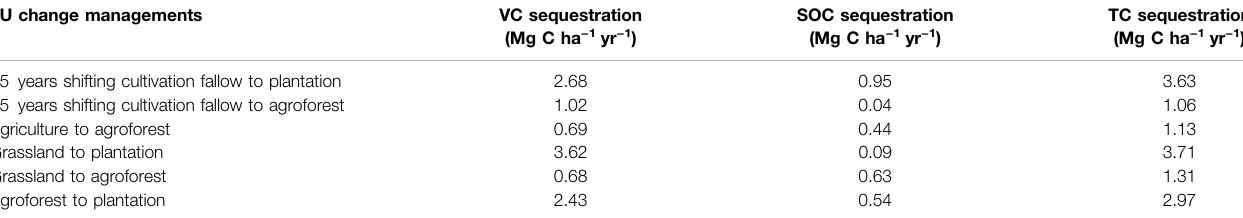
TABLE 5 | Vegetation carbon (VC), soil organic carbon (SOC), and total carbon (TC) sequestration after progressive land-use changes in Northeast India. LU change